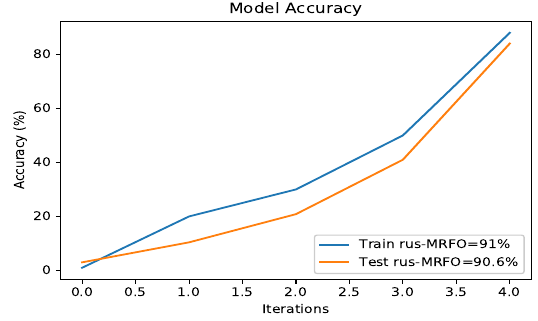
Figure 9. Accuracy rus-MRFO.